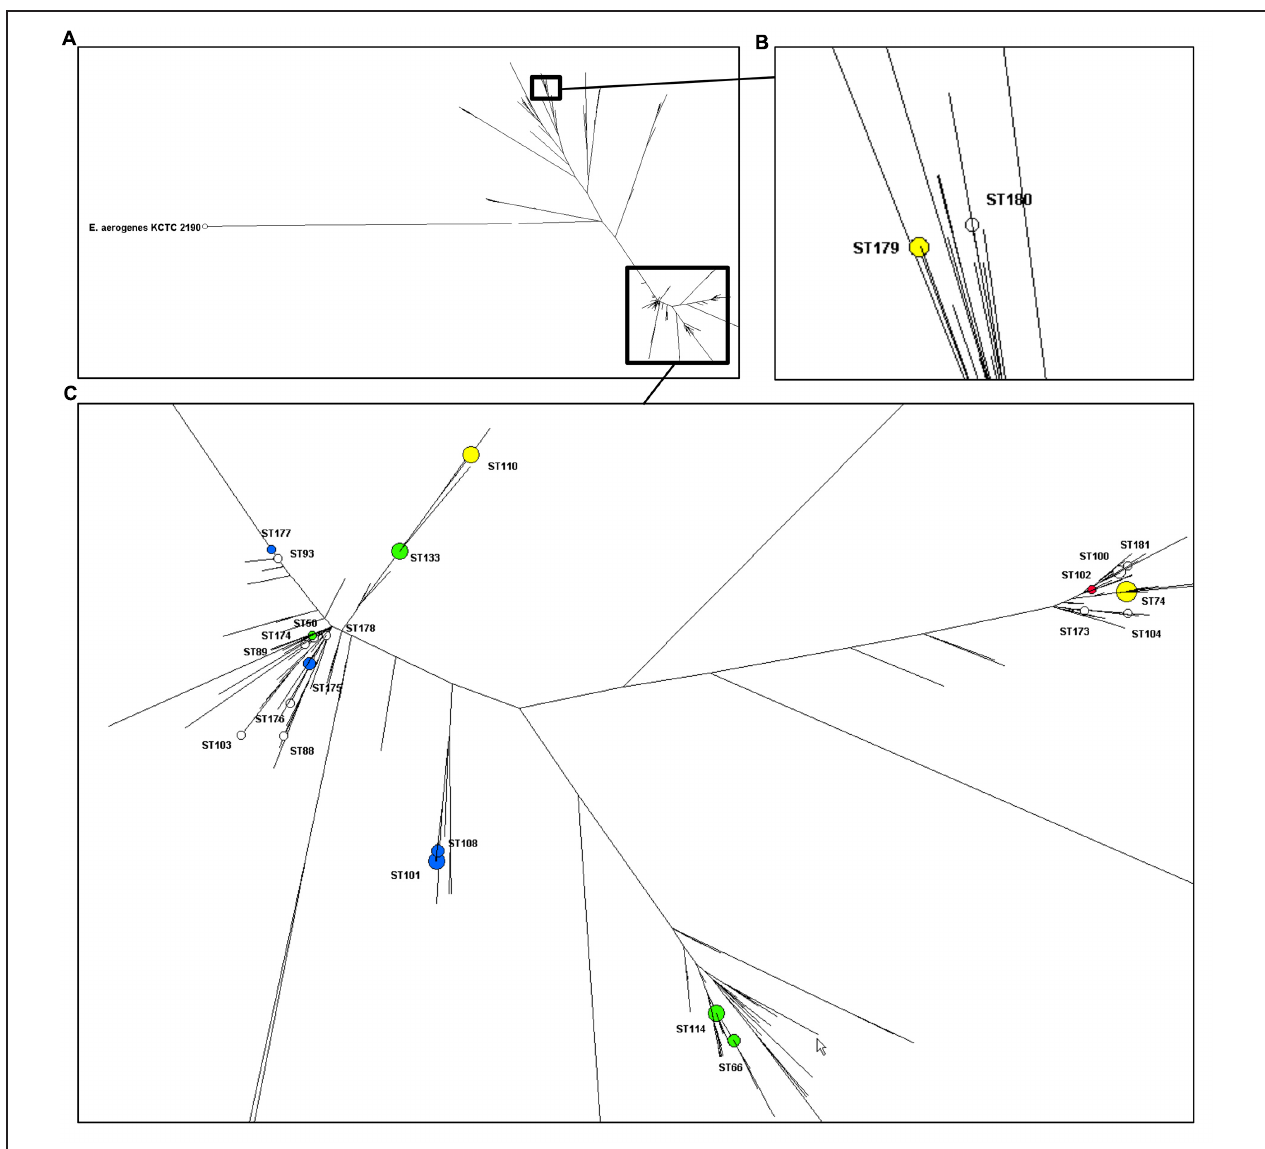
FIGURE 1 | Distribution of the STs of 75 clinical isolates of Enterobacter cloacae (non-susceptible to carbapenems and isolated in North-Eastern France) on a dendrogram built with the data all known STs ( n = 373). (A) Overview of the dendrogram with E. aerogenes as outgroup. (B) Close-up of the branch with ST179 and ST180. (C) Close-up the branch harboring the rest of the isolates described in this study. Enzymes in the different ST are represented with blue (SHV/TEM), yellow (OXA-48), green (CTX-M), and red (VIM) spots. Spots’ size depends on the amount of